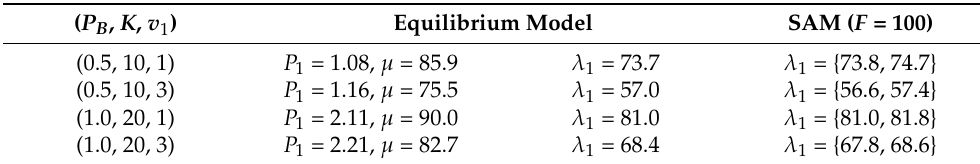
Table 1. Large capacity networks with frequent arrival rate broadcast (Case I).